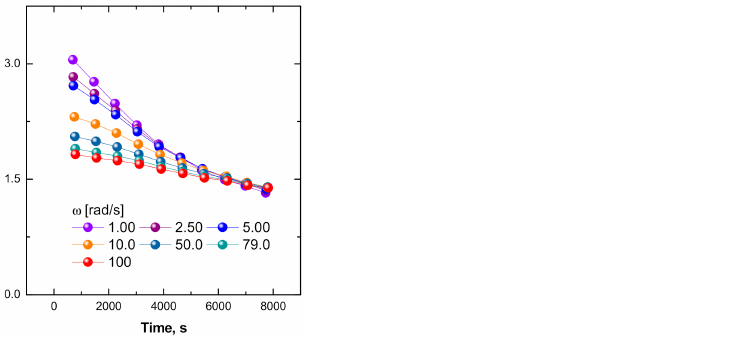
Figure 10. Multi-frequency plot for the variation of tan δ as a function of time for ENR+SiO 2